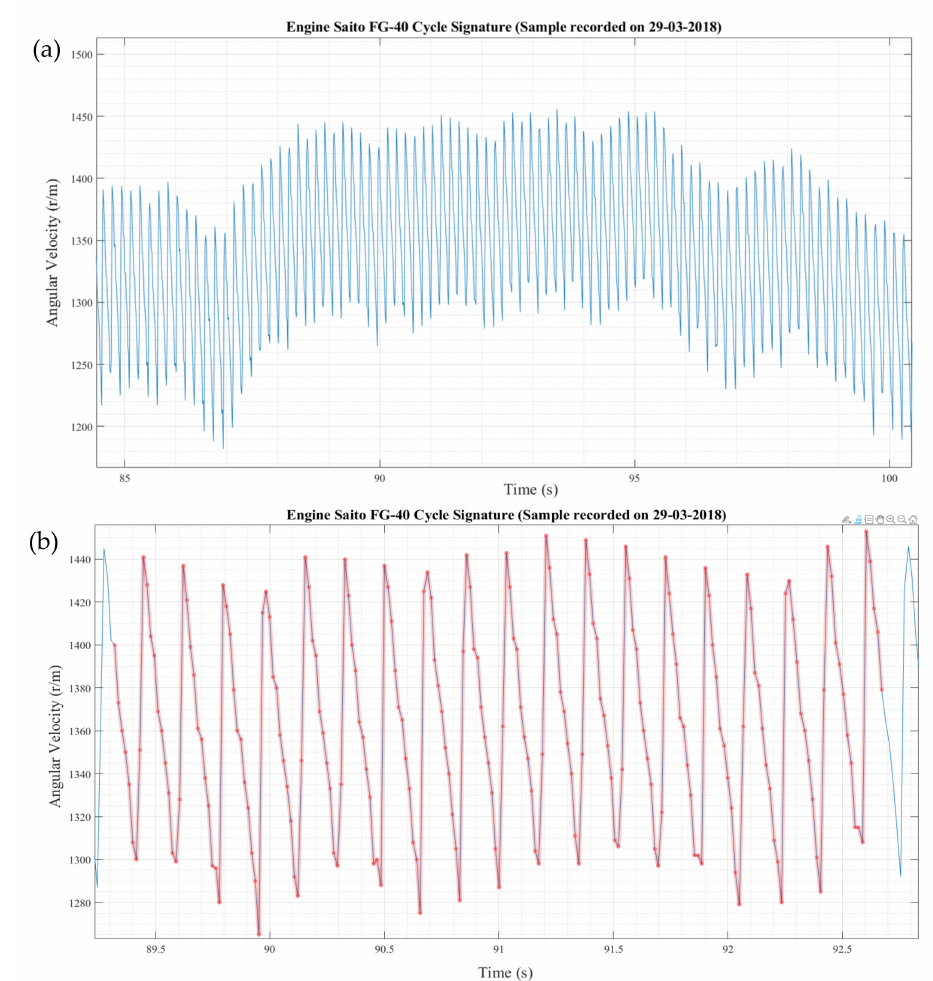
Figure 4. Fine details of speed evolution of the Saito FG-40